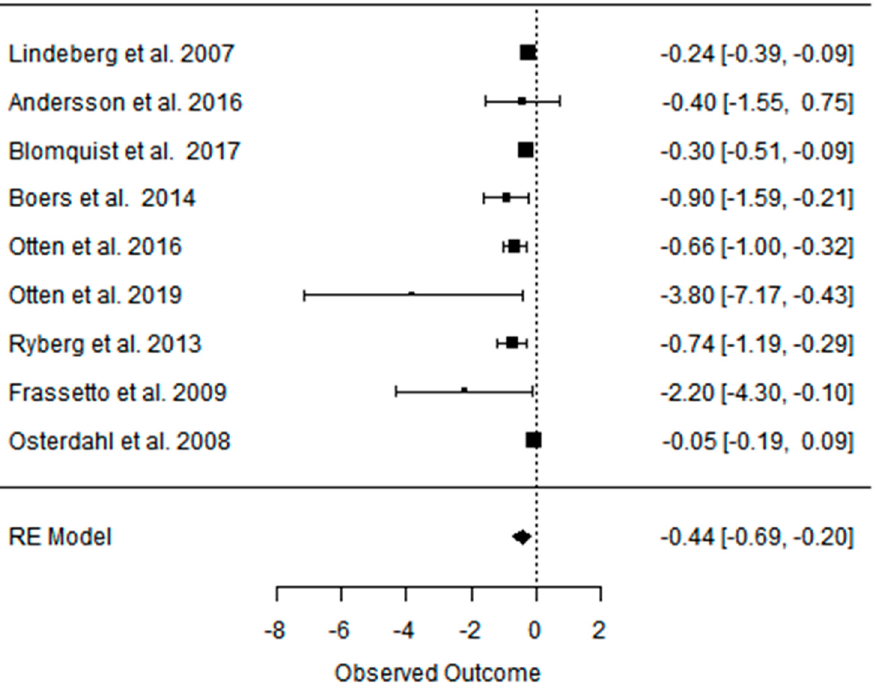
Figure A51. Forest plot of the effect of PD on HOMA-IR in the short term (weighted mean difference). Figure A50. Forest plot of the effect of a PDs on HOMA-IR in the short term (weighted mean dif- ference).